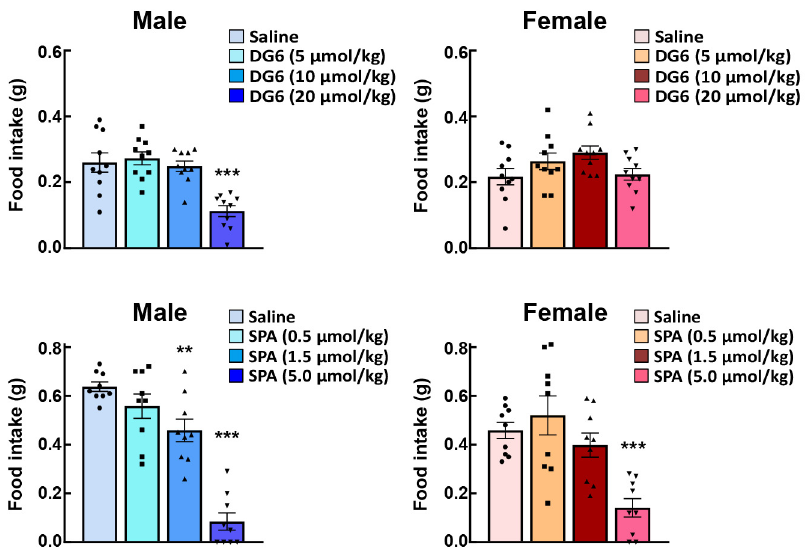
Figure 4. Effects of intraperitoneal administration of GHSR antagonists on the food intake of male and female naïve mice. The upper row shows the effects of (D-Lys 3 )-GHRP-6 (DG6) on 2-h food intake, and the lower row shows the effects of (D-Arg 1 , D-Phe 5 , D-Trp 7,9 , Leu 11 )-substance P (SPA) on 2-h food intake. **, *** p < 0.01, 0.001 vs. saline by Dunnett test. See the ghrelin administration section for a dosing schedule. n = 9 –1 0.